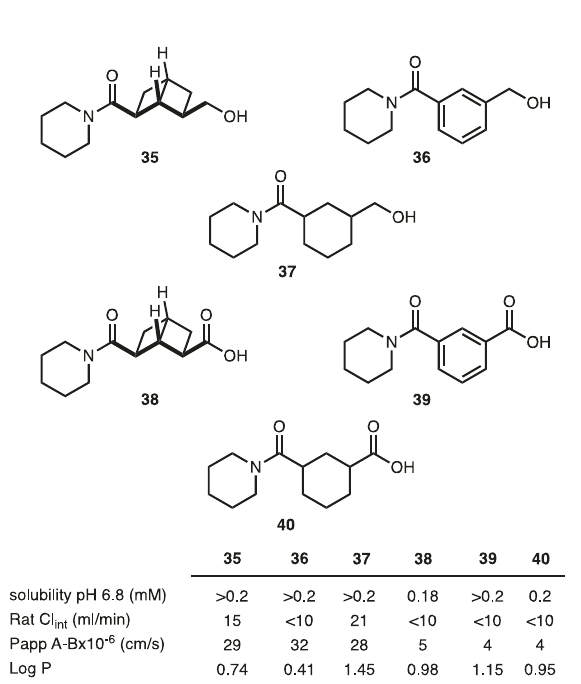
Fig. 5 | Preliminary comparisons to arenes/cyclohexanes. Evaluation of the ladderane, aryl, and cyclohexyl compounds shows little difference in the physico- chemical